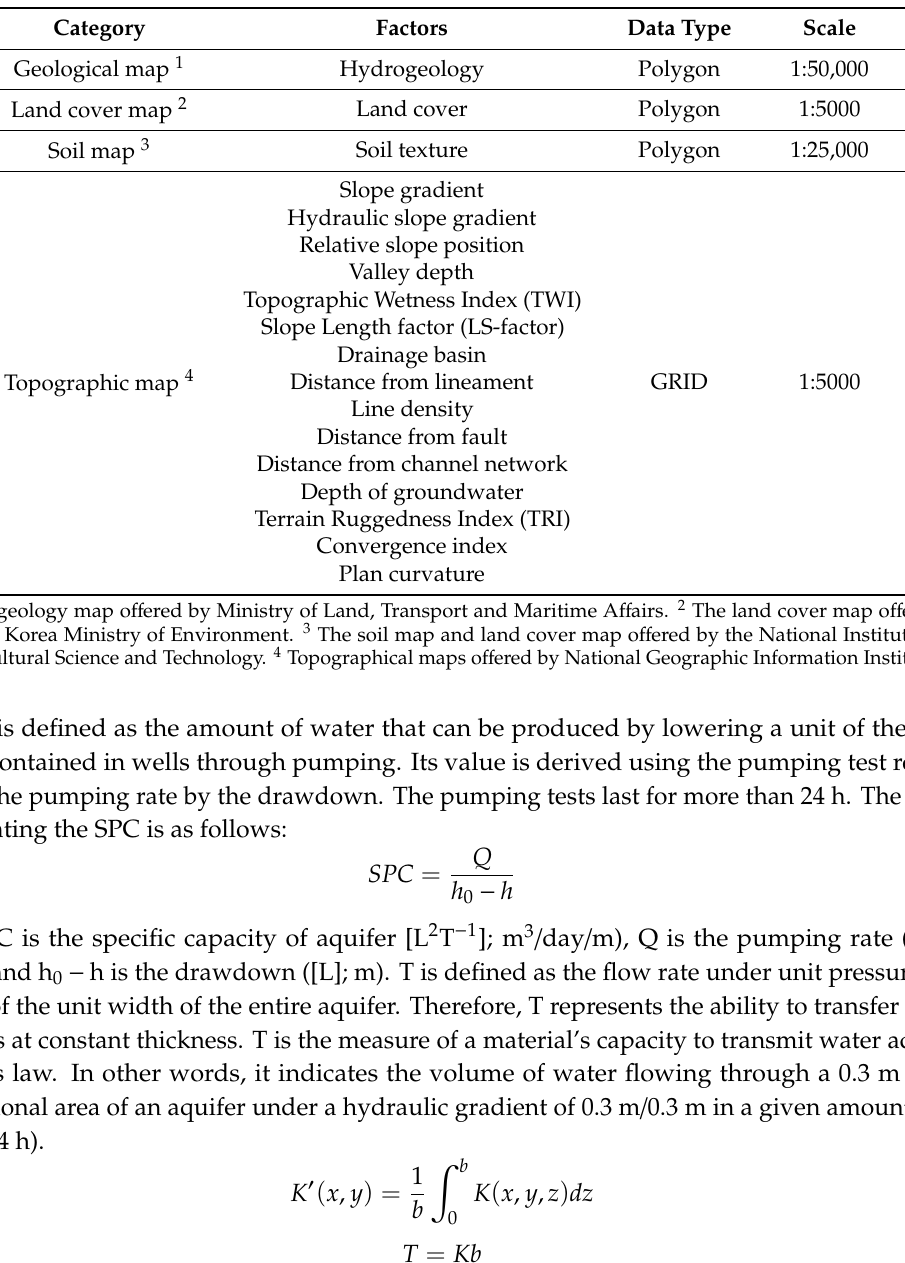
Table 1. Spatial data set related to groundwater of the study